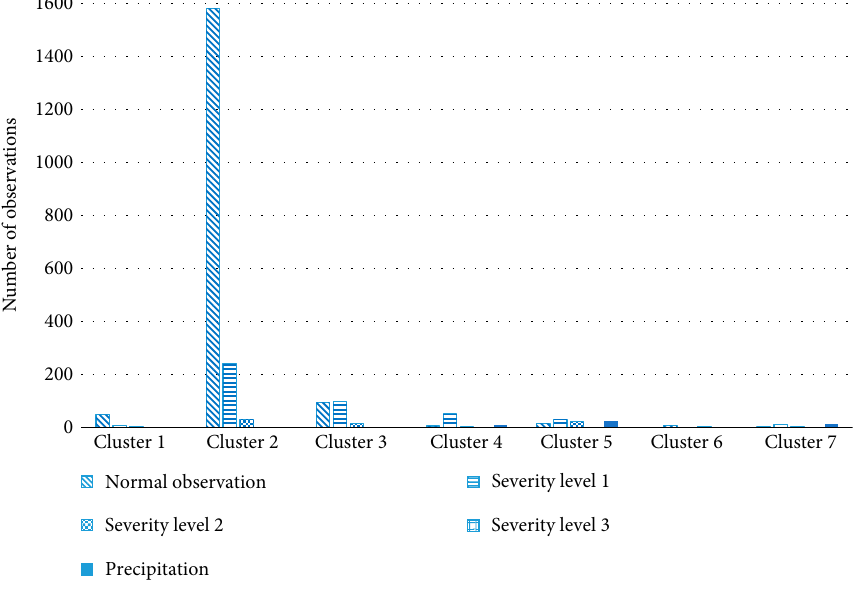
Figure 8: Observations in each cluster when using hierarchical clustering with the complete linkage.